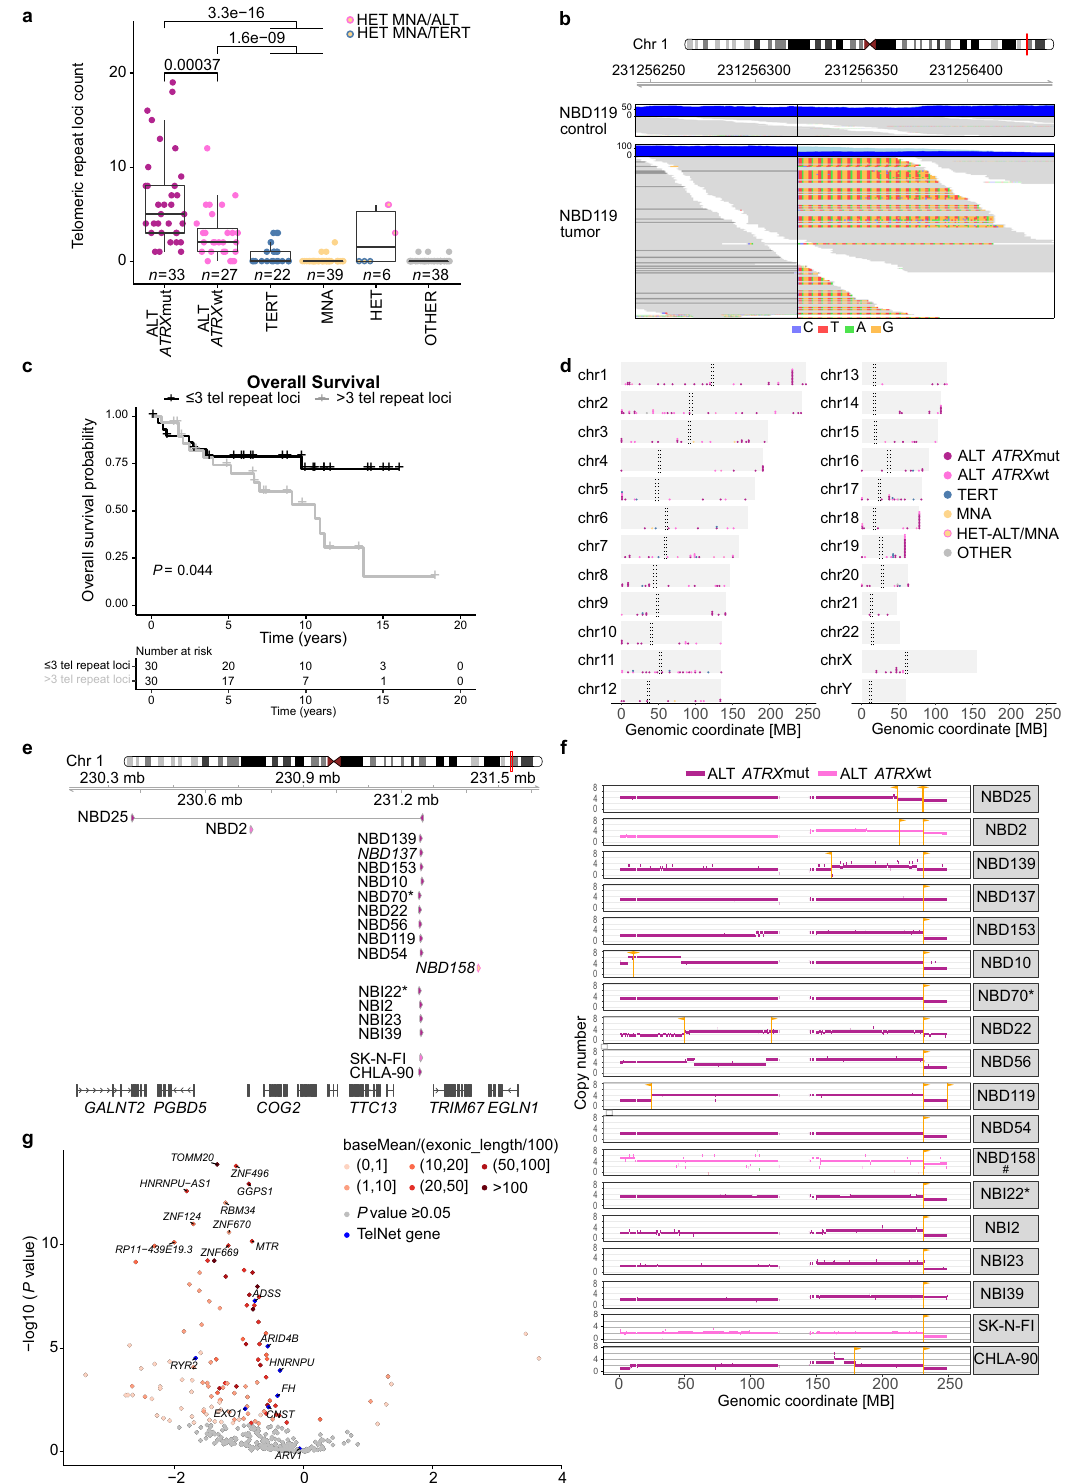
diagnosed as low or intermediate risk, but nevertheless had poor outcome. The current standard treatment regimens tar- geting strongly proliferating tumors are probably not suited to treat slowly growing ALT tumors, which might lead to a selection and enrichment of ALT-positive cases or subclones in the relapse setting. Thus, ALT activation might present a